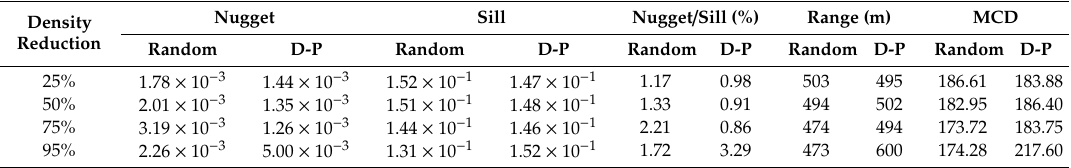
Table 6. Best fit variogram parameters for the natural logarithm of soil ECa datasets, based on the di ff erent sample density reduction methods and levels.